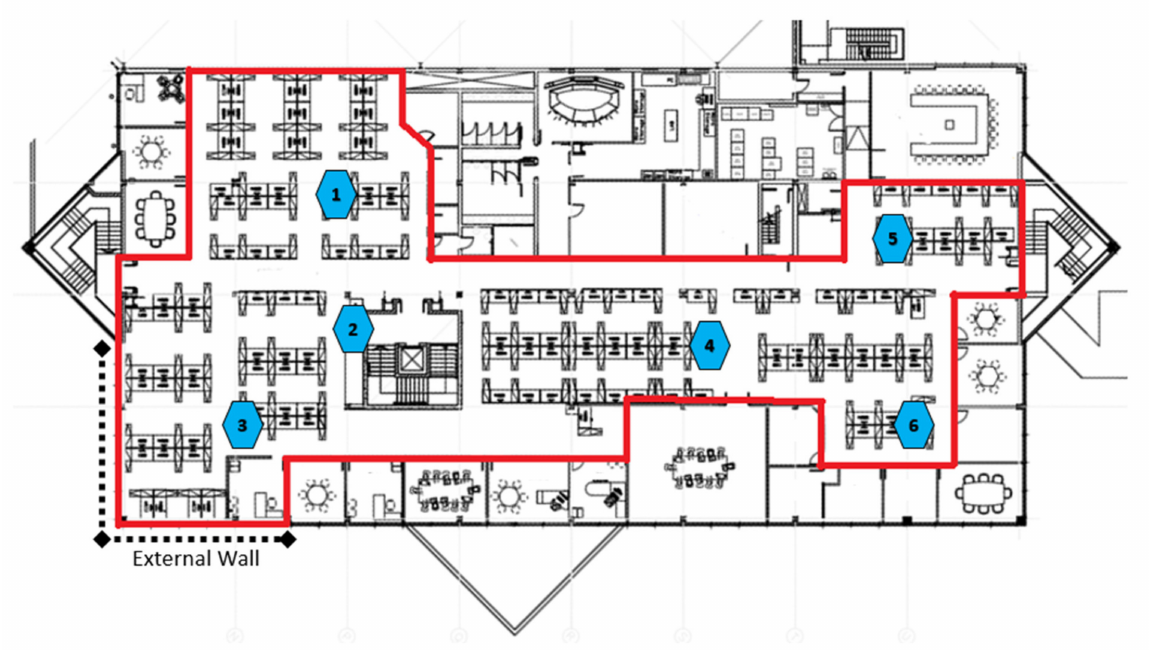
Figure 3. Overview of zone (red boundary line) and sensor locations marked (1 – 6) within the open plan office space used for model